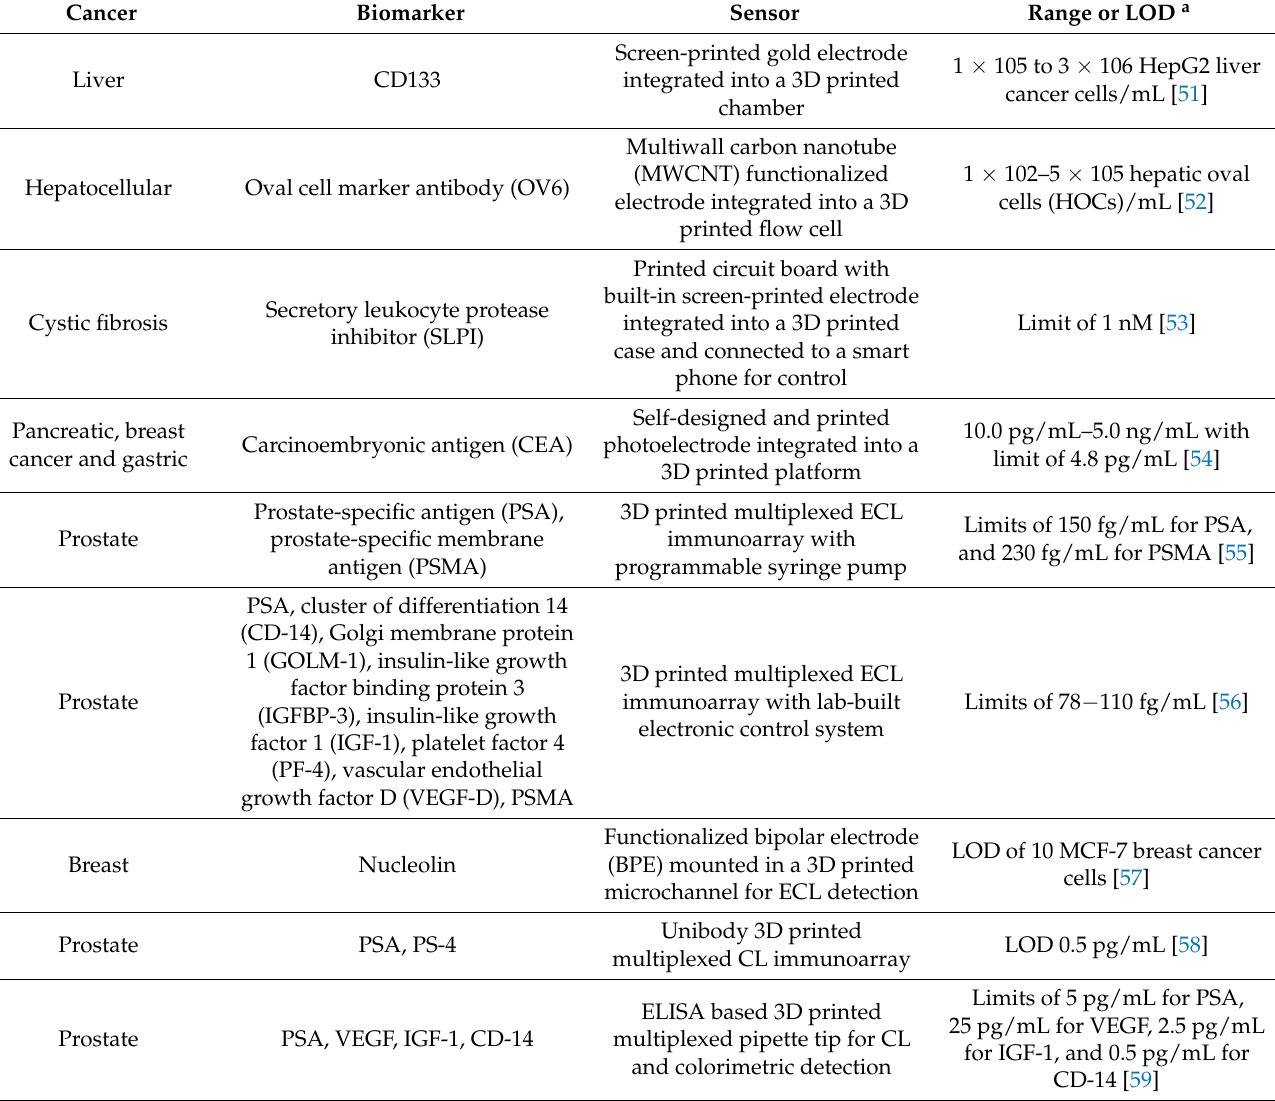
Table 3. Selected 3D-printed biomarker-based cancer diagnostic devices